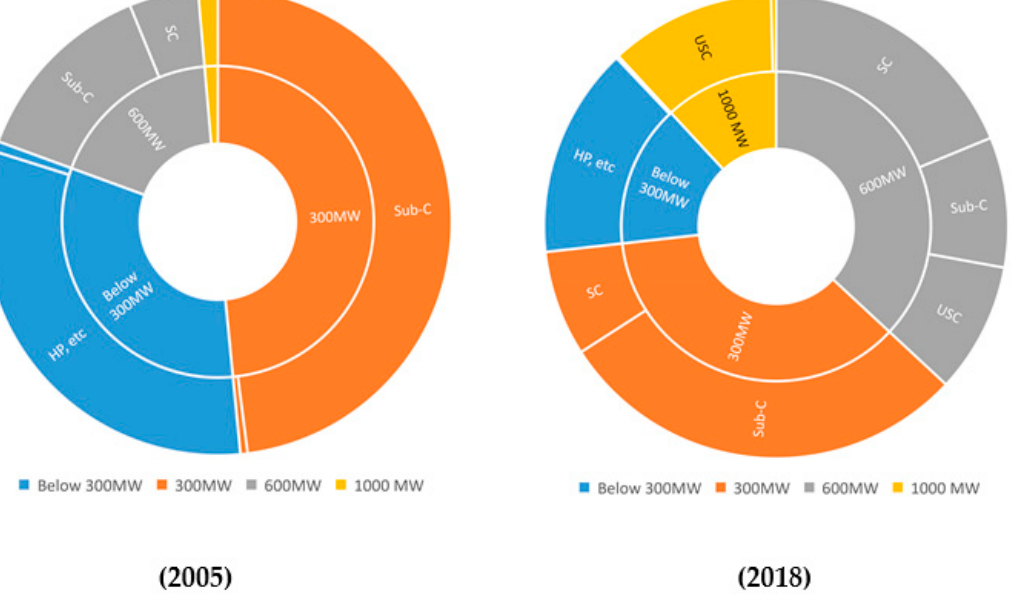
Figure 5. Structure of the coal-fired power capacity in 2005 and 2018.